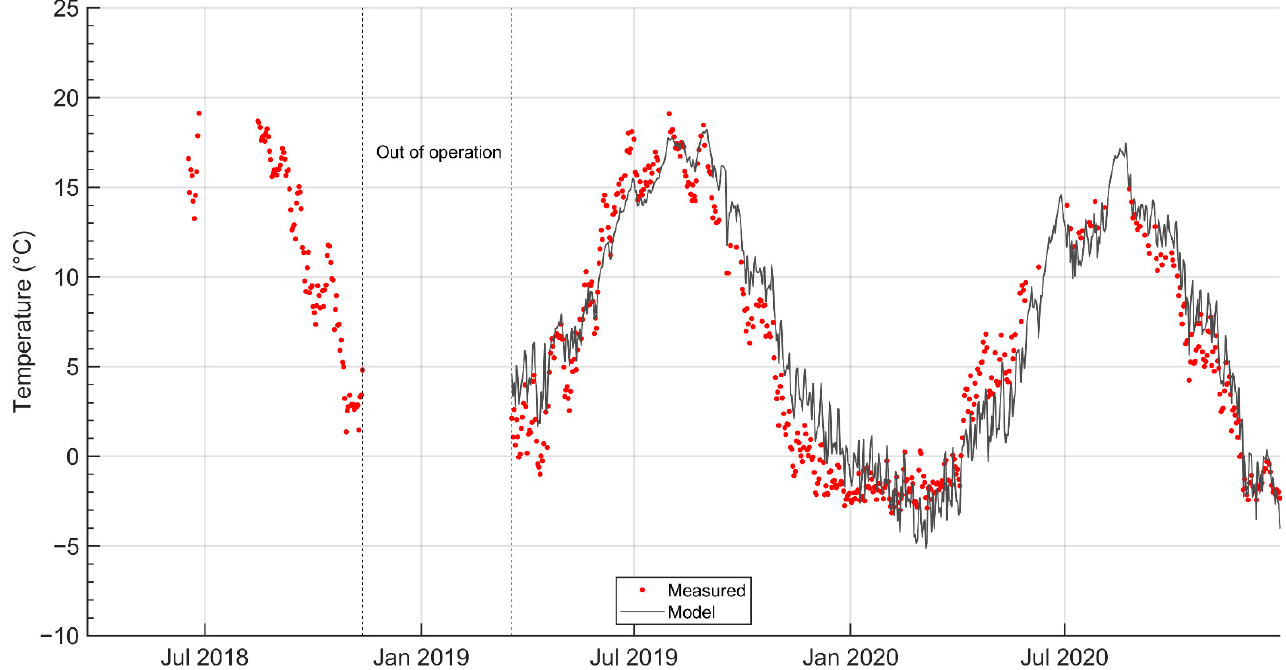
Figure 12. Model predictions of brine temperatures entering the cold side of the heat pump and corresponding measured brine temperatures.